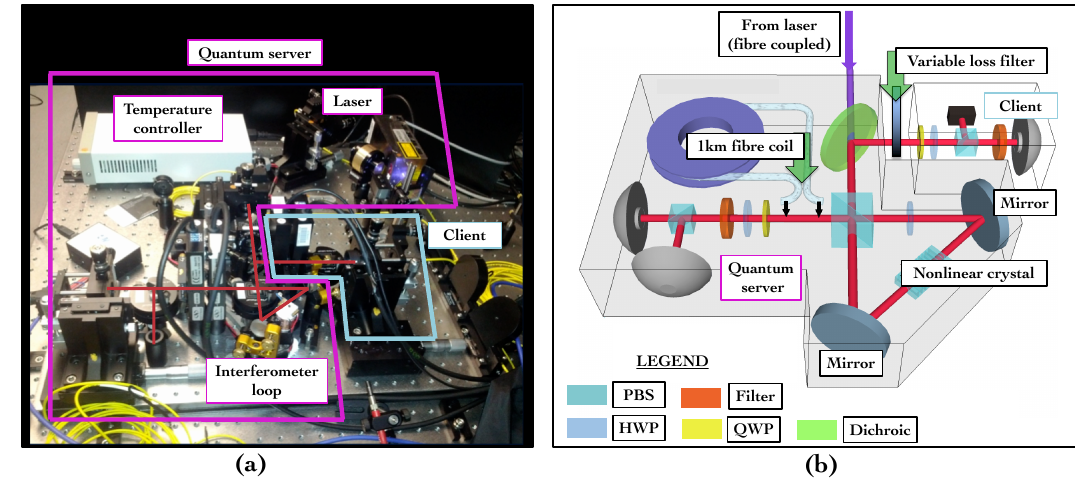
Fig. 4. An entanglement source based upon a polarisation Sagnac interferometer, equiv- alent to a simplified quantum server. (a) A photograph of the experimental apparatus used in previous experimental demonstrations (testing the loss-tolerance and viability of the en- tanglement verification protocols). The device is compact, fitting on a 600x600mm board, and readily functions as a quantum server/quantum modem pair for implementing the PoE mining protocol. (b) The server and client devices are energy-efficient, consisting mostly of passive optical elements, which include polarising beam splitters (PBS), wavelength fil- ters, silvered and dichroic mirrors, an optical fibre line, a variable loss neutral-density filter, and half waveplates (HWP) and quarter waveplates (QWP) for implementing the polarisation measurements required to test entanglement witnesses based upon loss-tolerant EPR steering inequalities (see main text for